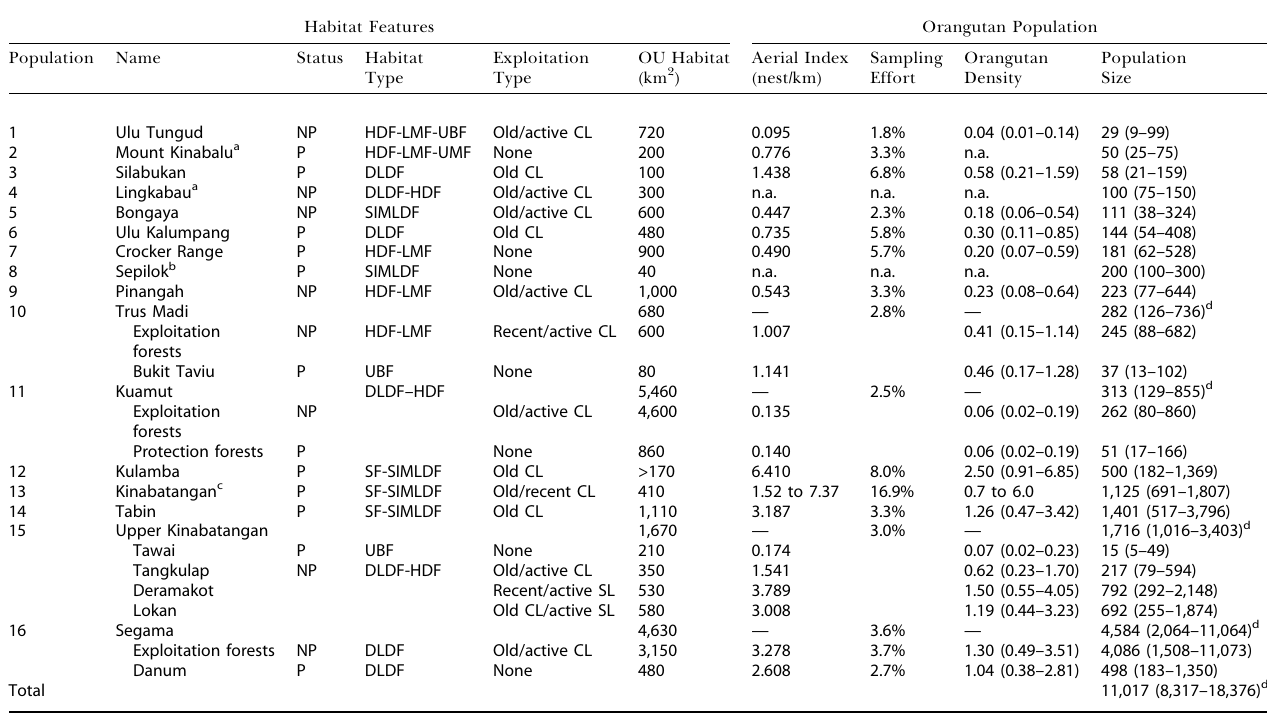
Table 2. Area Name and Size of Habitat Occupied by Orangutans, Aerial Indexes, Nest and Orangutan Densities, and Final Population-Size Estimates for the 16 Major Orangutan Populations Identified during the Surveys in Sabah, Malaysia,